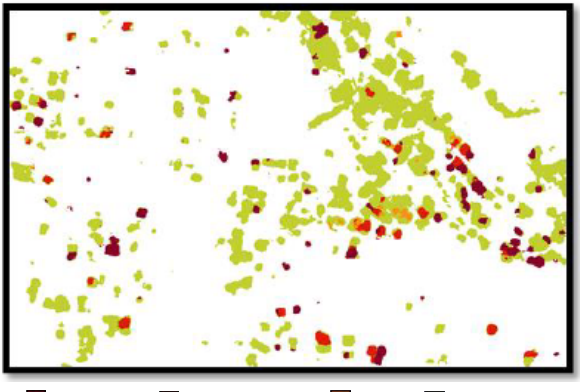
Figure 13. Haiti damages